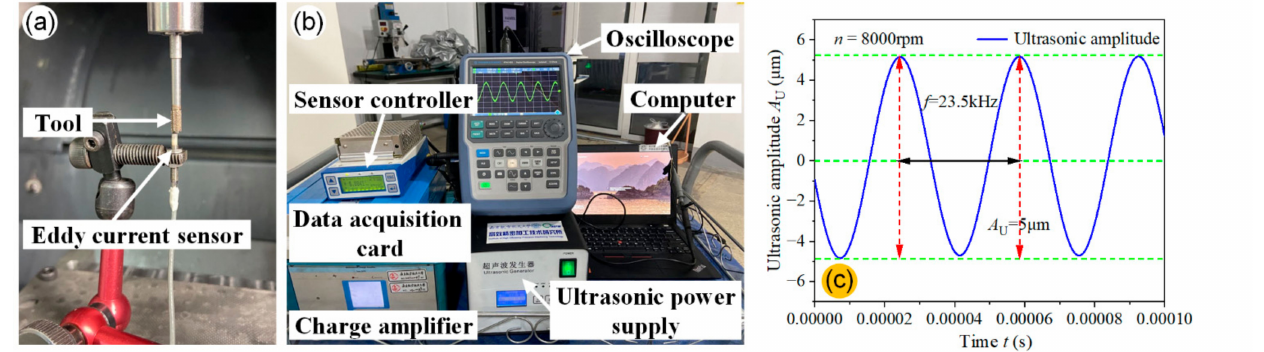
Figure 4. Ultrasonic amplitude testing device, ( a ) eddy current sensor, ( b ) dynamometer and ampli- tude measurement controller, ( c ) axial ultrasonic amplitude at 8000